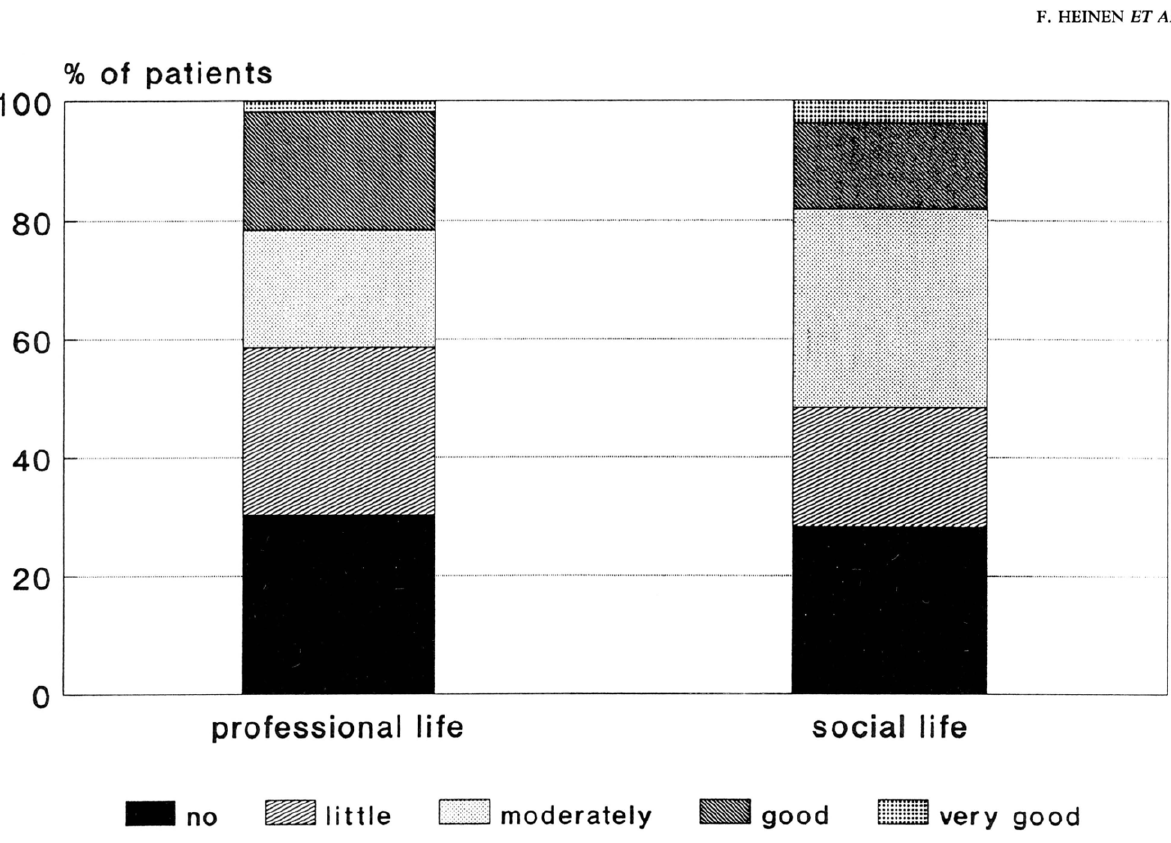
FIG. 4. Patients' assessments of improvement in their professional and social lives as a result of treatment with botulinum toxin A.